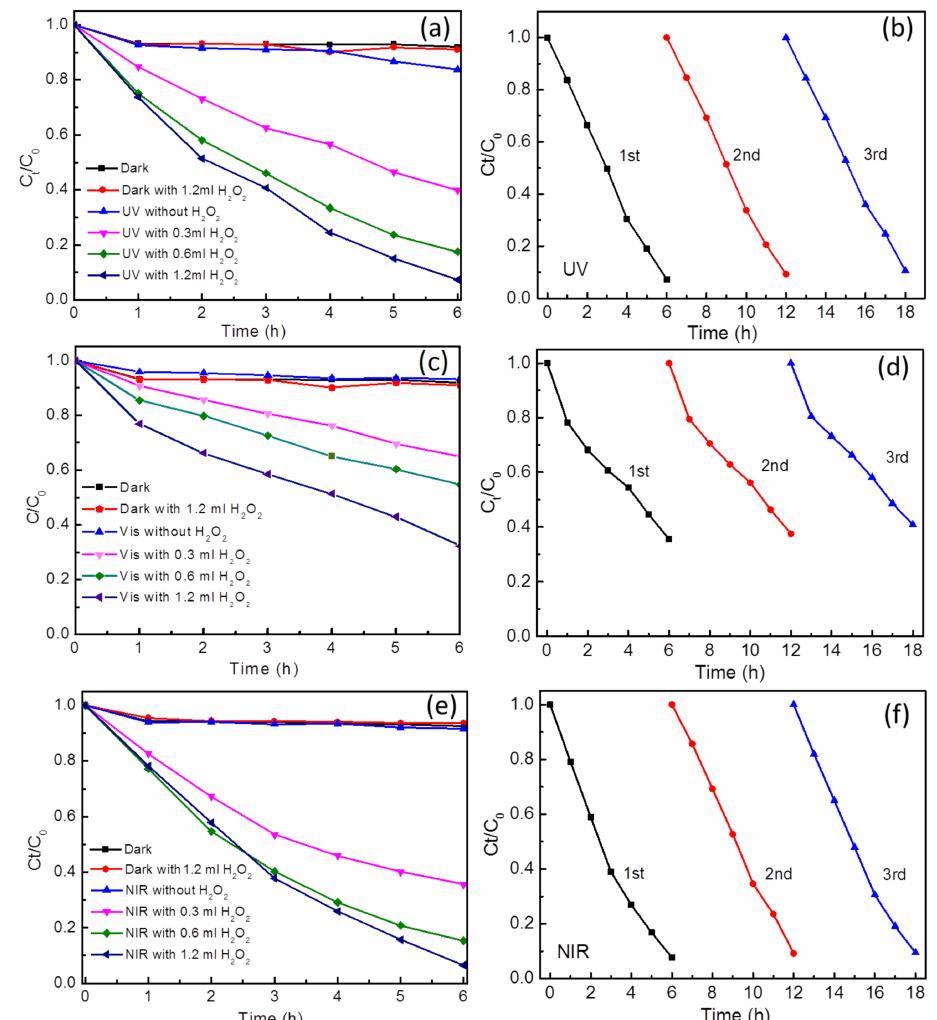
Figure 4. Photocatalytic degradation of MO using ZnO/CuO/ZnFe 2 O 4 nanocomposite (left) and recycled ZnO/CuO/ZnFe 2 O 4 nanocomposite (right) in the presence of H 2 O 2 under ( a , b ) UV, ( c , d ) visible and ( e , f ) NIR light irradiation. The concentration of H 2 O 2 is 10 wt. %. The